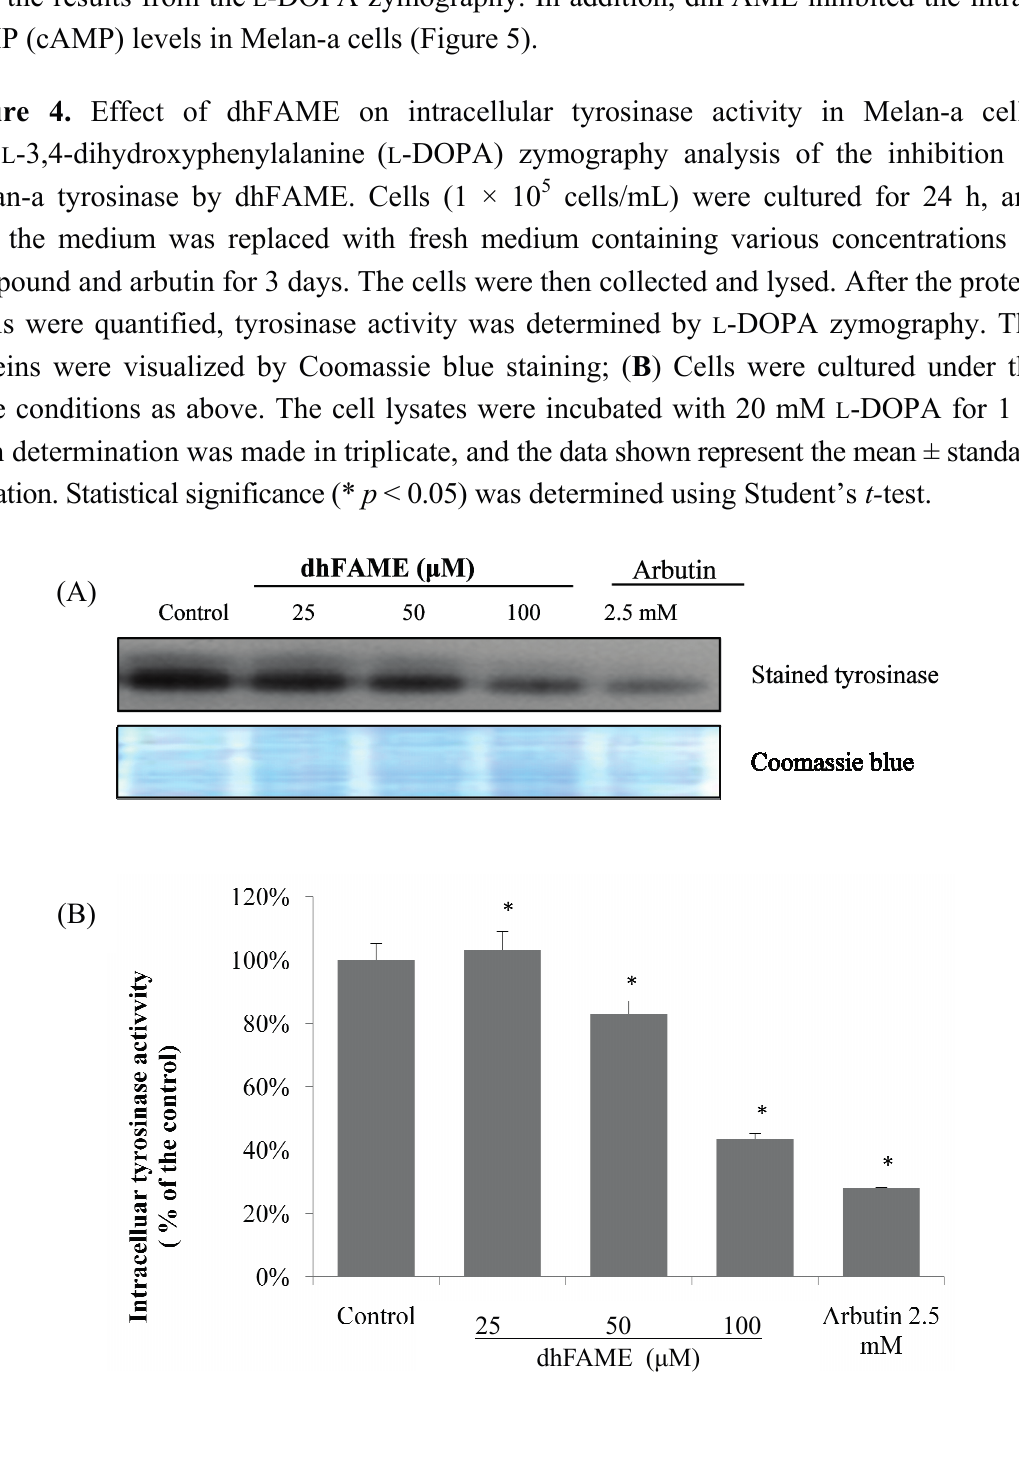
Figure 4. Effect of dhFAME on intracellular tyrosinase activity in Melan-a